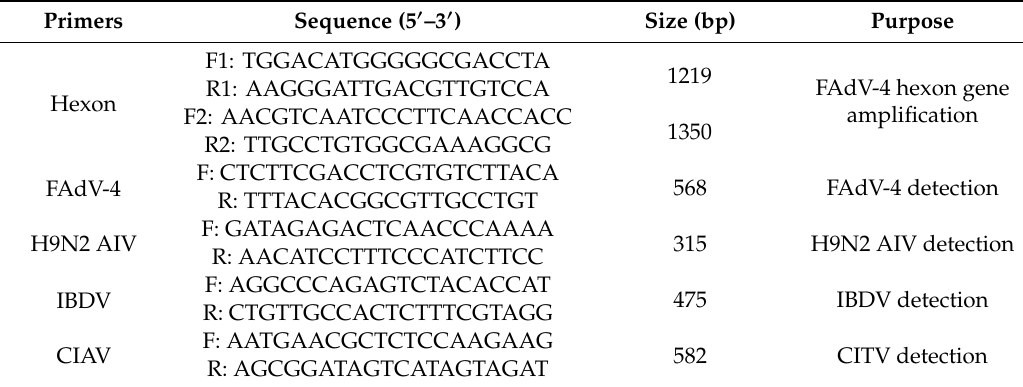
Table 1. Primers used in this